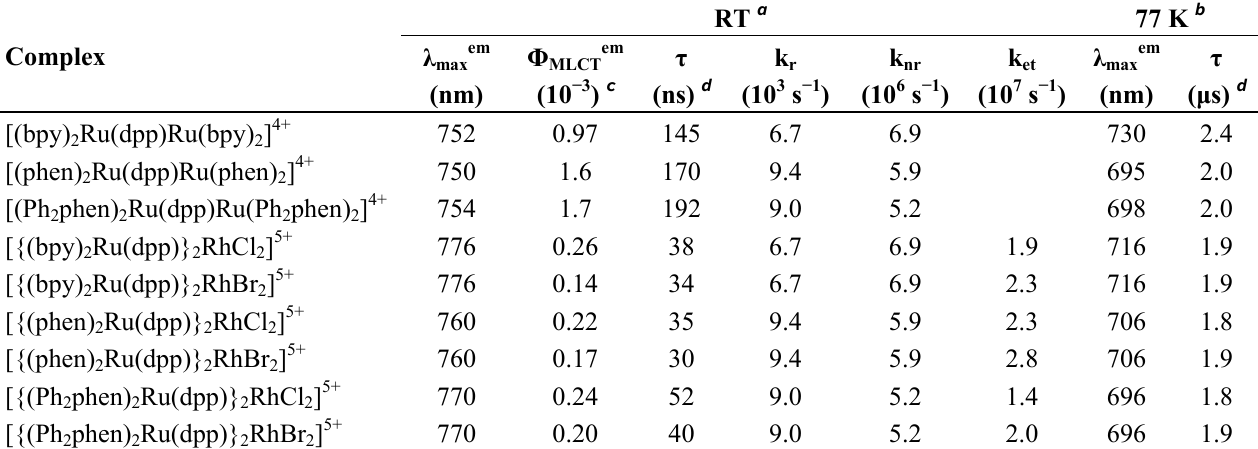
Ru(dpp)} RhX ] 5+ Trimetallic and Analogous 2 2 2